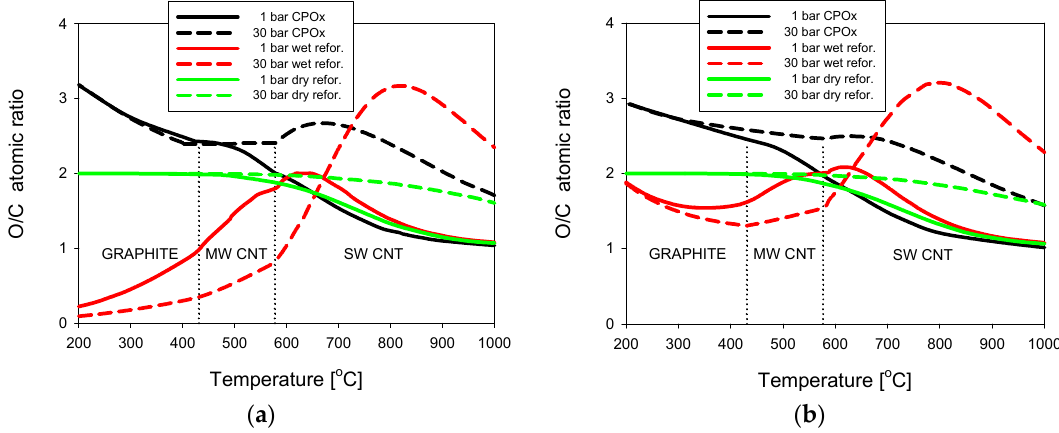
Figure 5. Critical O/C lines for the catalytic partial oxidation reforming (CPOx), wet and dry reformates of: ( a ) natural gas; and ( b ) liquefied petroleum gas.